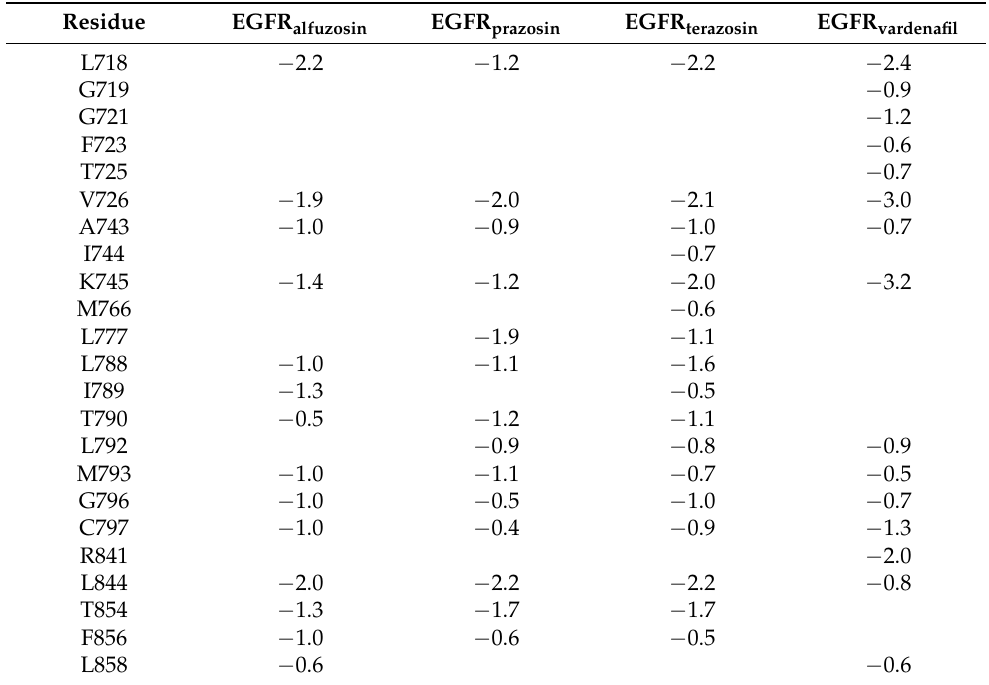
Table 5. Per-residue free energy for complexes formed between alfuzosin, prazosin, terazosin, and vardenafil with EGFR (values